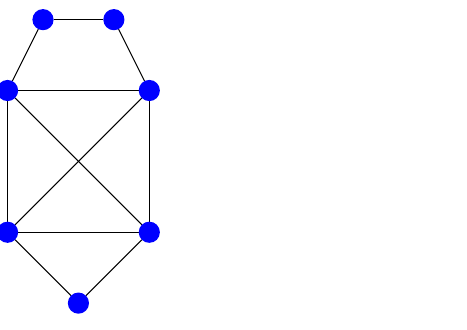
Figure 3. The first cospectral graph with seven vertices.